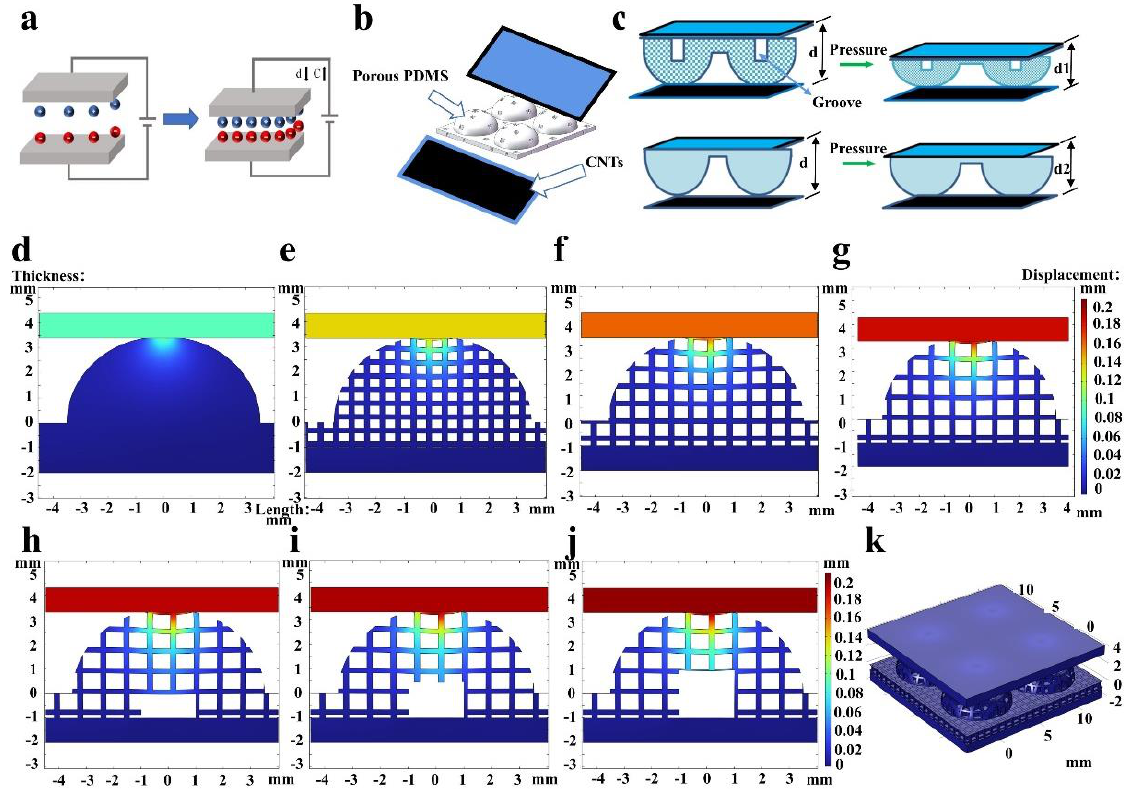
Figure 2. Working principle sketch map and simulation charts. ( a ) Working principle of the plane − parallel capacitive pressure sensor. ( b ) Structure of the PHHDL−based pressure sensor. ( c ) Schematic illustration showing the structure deformation procedure when the dielectric layer is porous, hollow, and non-patterned. ( d – k ) Simulation schematics of the pressure sensor when a pressure of 1 kPa is applied to the sensor.